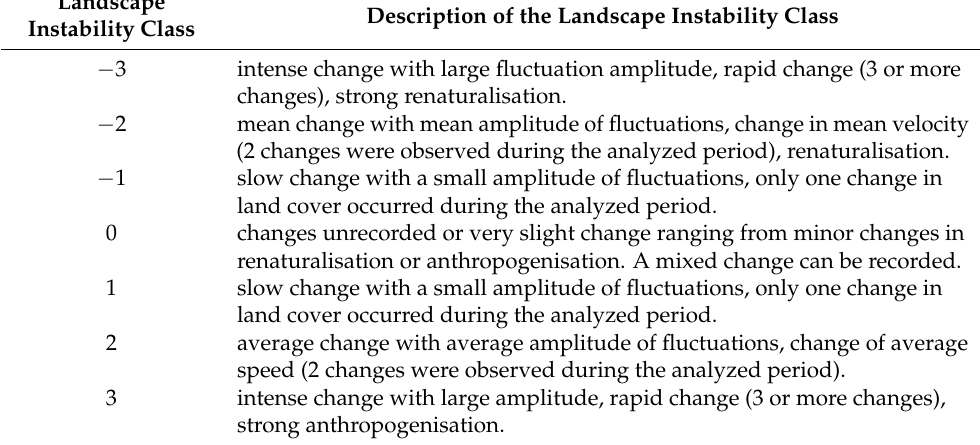
Table 3. Landscape instability classes and their